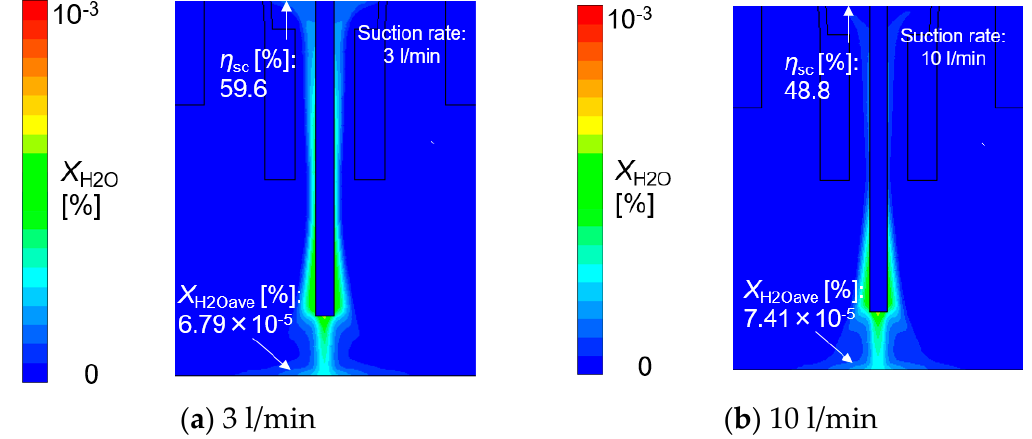
Figure 12. The effect of the suction rate on the mole fraction of H 2 O : ( a ) 3 l/min, ( b ) 10 l/min.